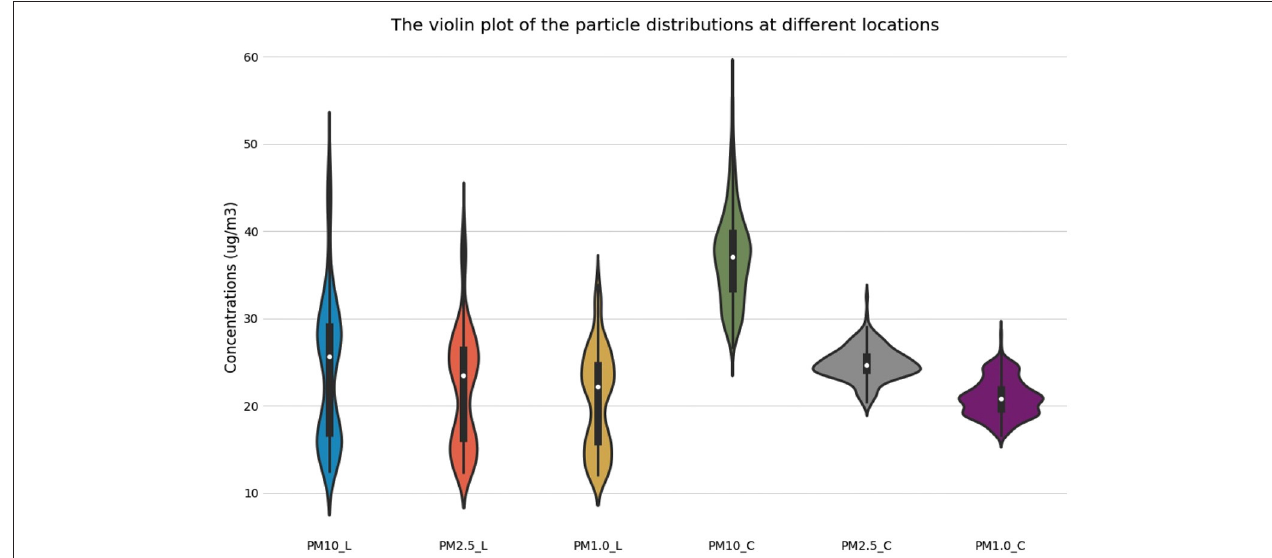
FIGURE 6 | The violin plot of the particle distributions at different locations.